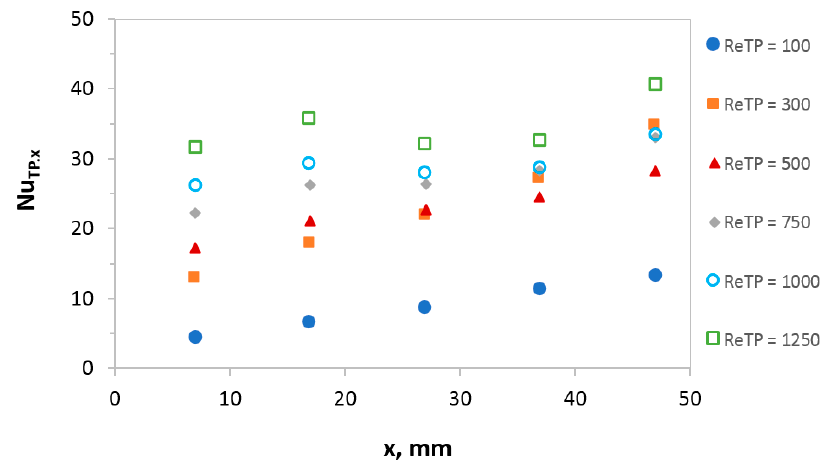
Figure 7. Dependence of the local Nusselt number on MFHE axial location for two-phase flow at Re TP = 100–1250, φ = 10%. Re TP = 100–1250, ϕ = 10%.